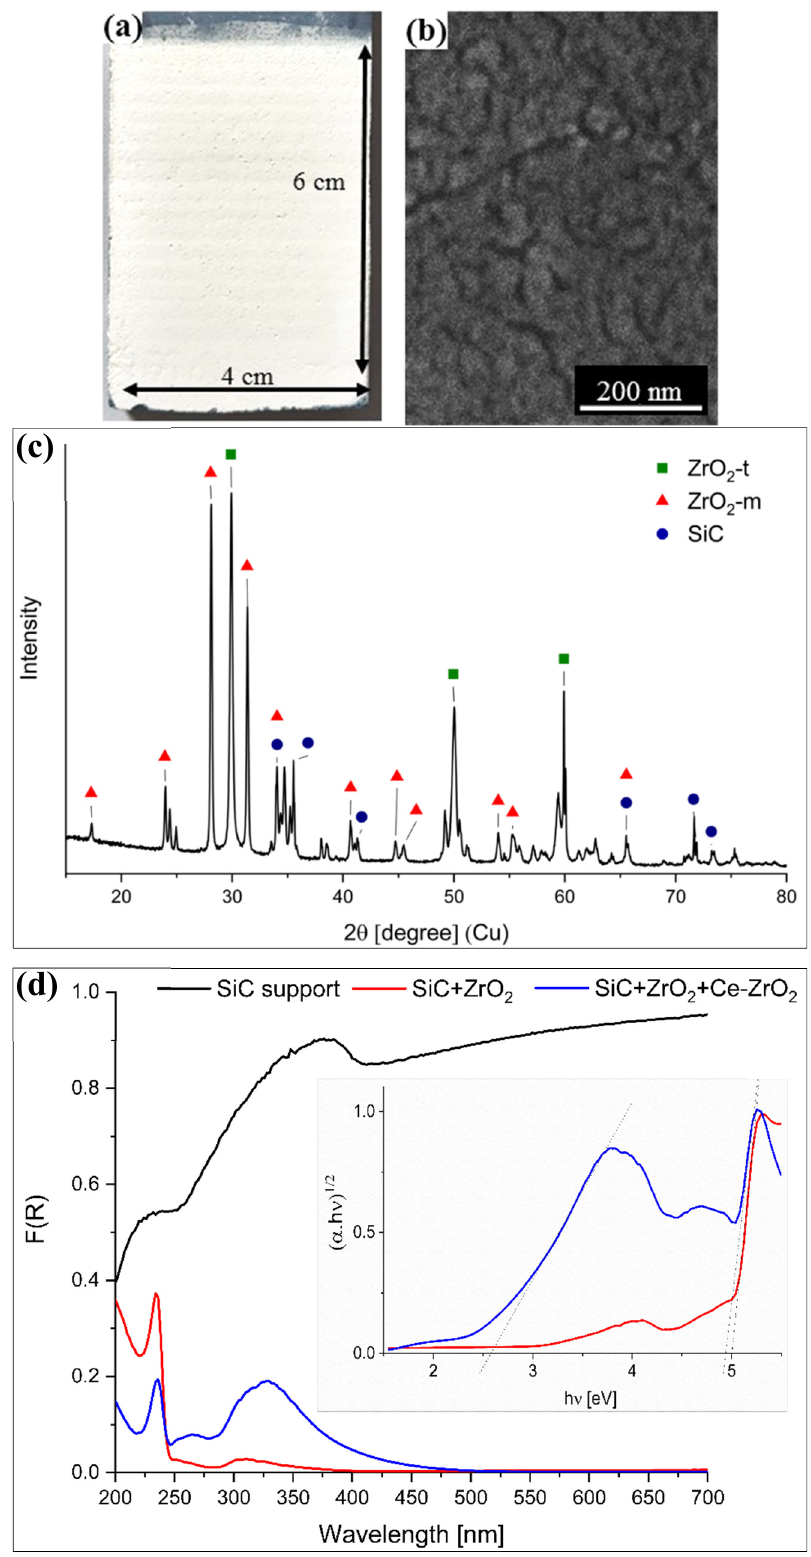
Figure 8. ( a ) Photo, ( b ) FE—EM image, and ( c ) X-ray di ff ractogram of the immobilized Ce–ZrO 2 on the silicon carbide (SiC) support. ( d ) Absorbance spectra of the samples obtained by applying the Kubelka–Munk function, F(R), to the di ff use reflectance spectra. The inset is the Tauc plot of the SiC support + ZrO 2 intermediate layer and the immobilized Ce–ZrO 2 .